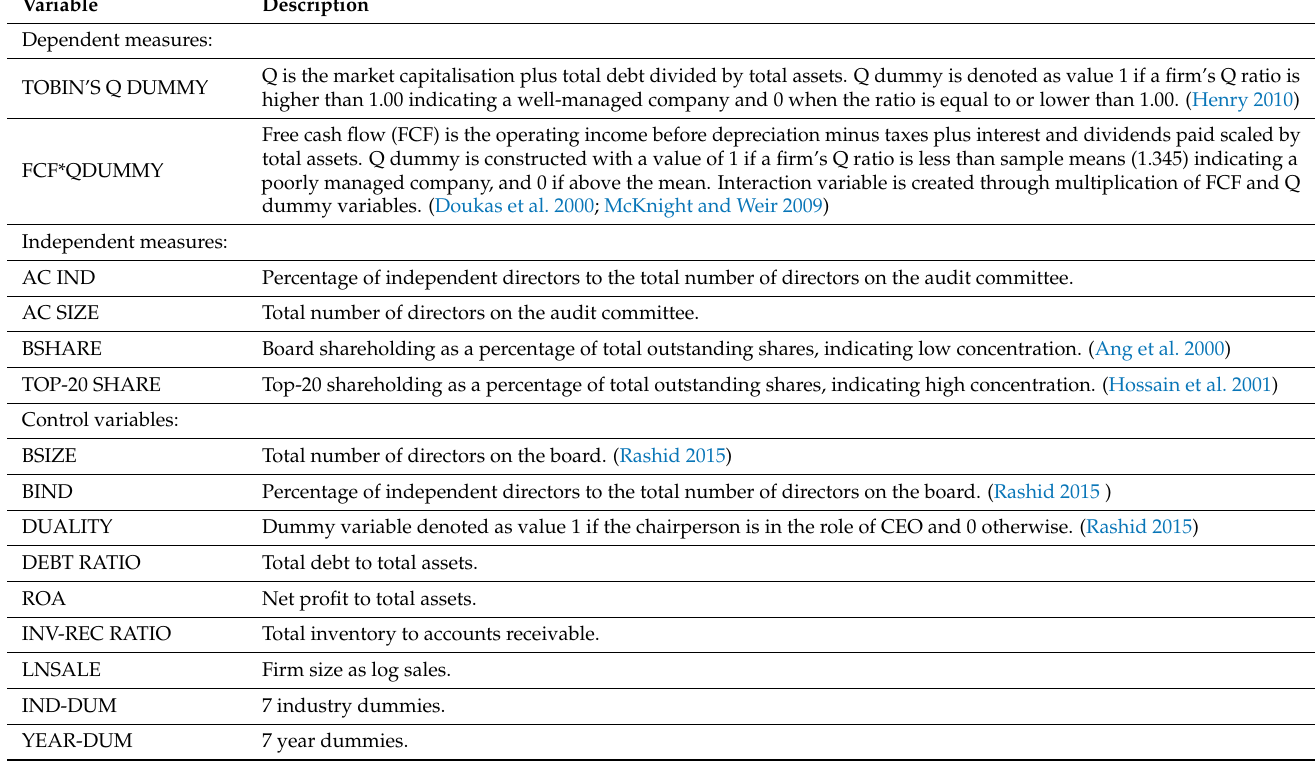
Table 2. Variable